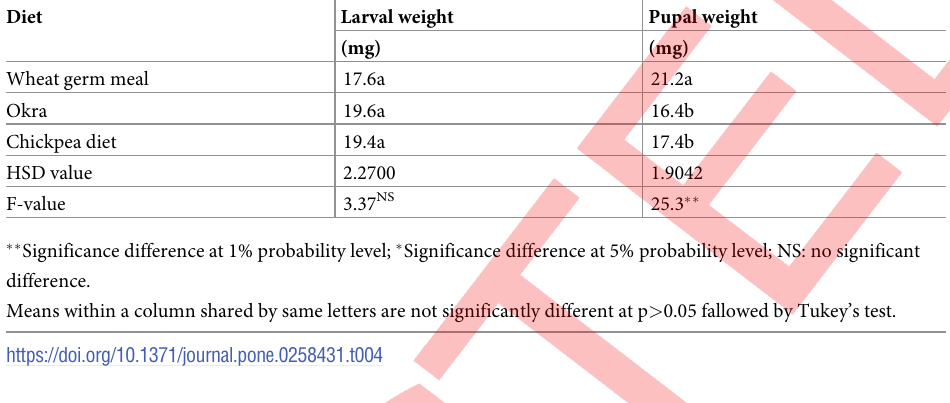
Table 4. Mean comparison of larval and pupal weights of pink bollworm reared on three treatment diets. Diet